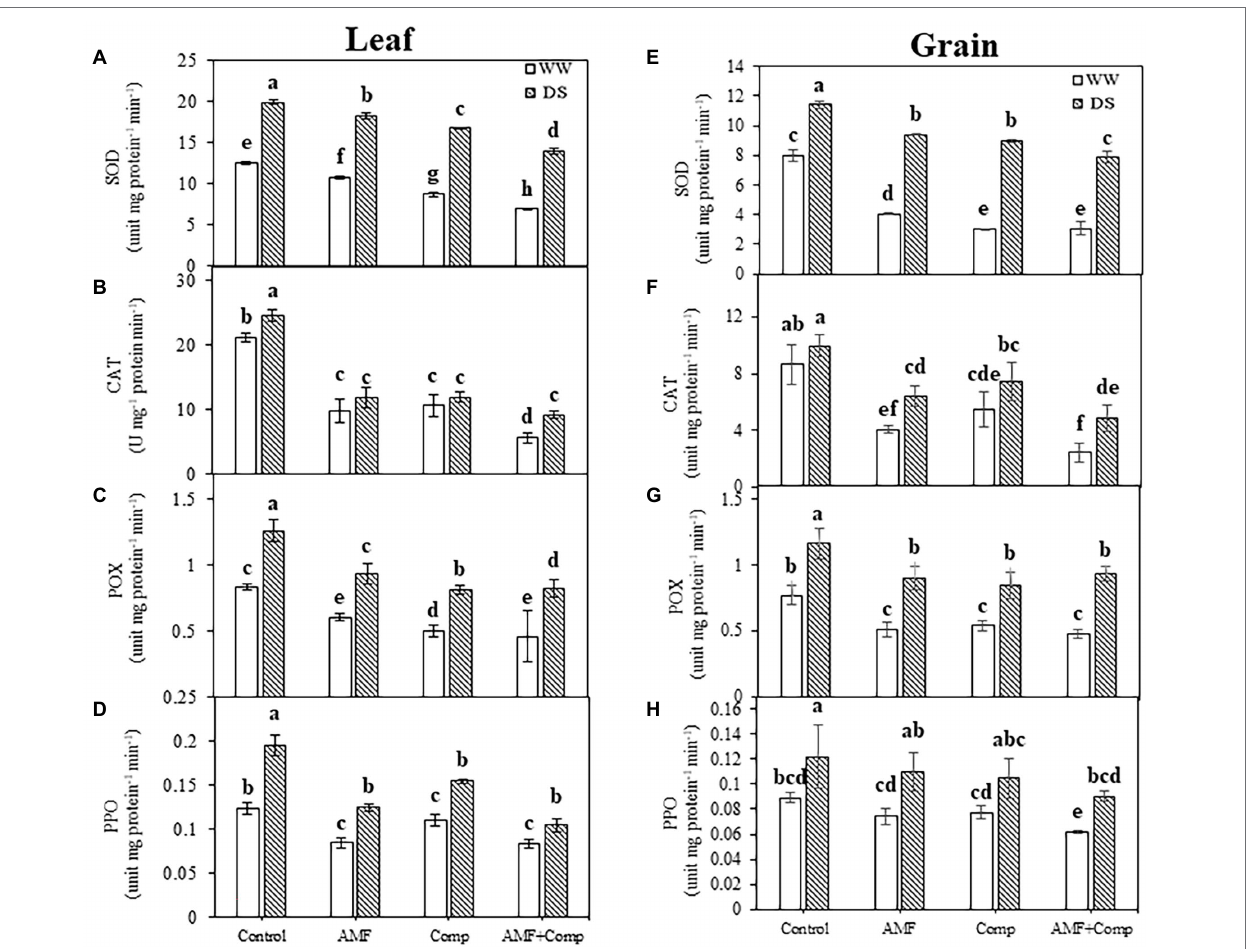
FIGURE 4 | Effects of water regimes (WW; well-watered or DS: drought stress) on leaves and seeds antioxidant enzyme activity (A,E) superoxide dismutase (SOD), (B,F) catalase (CAT), (C,G) peroxidase (POX), and (D,H) polyphenol oxidase (PPO) of non-amended and non-inoculated quinoa (control), and quinoa inoculated with arbuscular mycorrhizal fungi (AMF) and/or amended with compost (Comp). Data are mean ± SD. Means followed by the same letters are not significantly different at p <